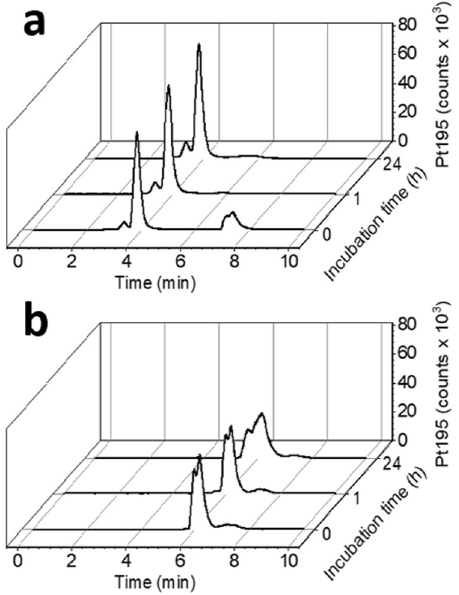
Fig. 3 Platinum-SEC-ICP-MS traces of BSO-OxMal and BSO-OxOAc. ( a ) shows BSO-OxMal and ( b ) BSO-OxOAc . The compounds were incubated in fetal calf serum at 37°C and measured after 0, 1, and 24h. The peaks at t r >6min represent low molecular weight platinum, the peak at t r ~4min albumin-bound platinum. The quantitative analysis of the albumin binding is summarized in Supplementary Table